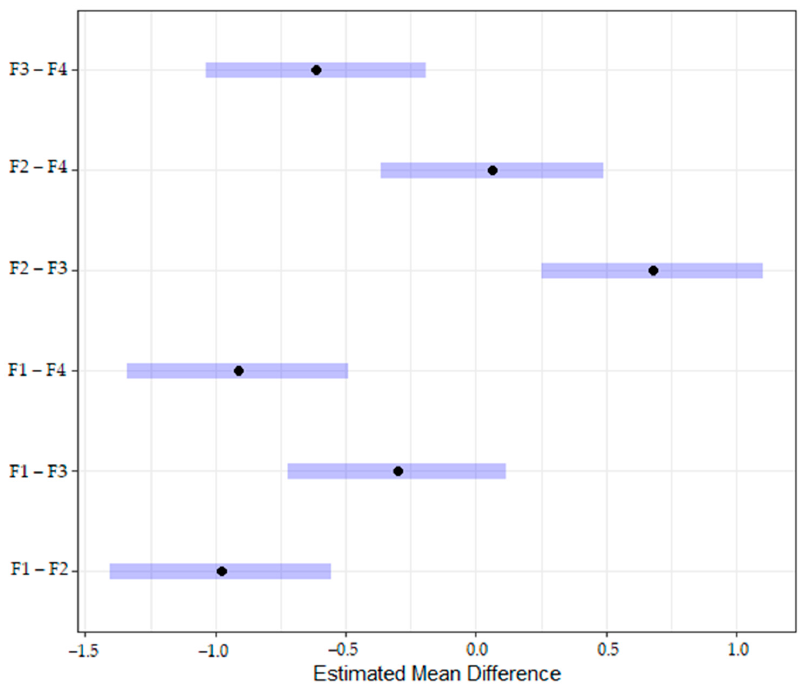
Figure 3. Estimated mean difference by each pair of speakers. F1–F4 refer to each female speaker who recorded the stimuli.